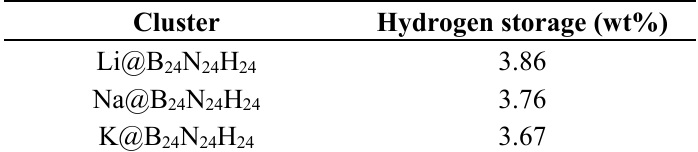
Table 7. Hydrogen storage capacity of chemisorption on nitrogen position of M@B 24 N 24